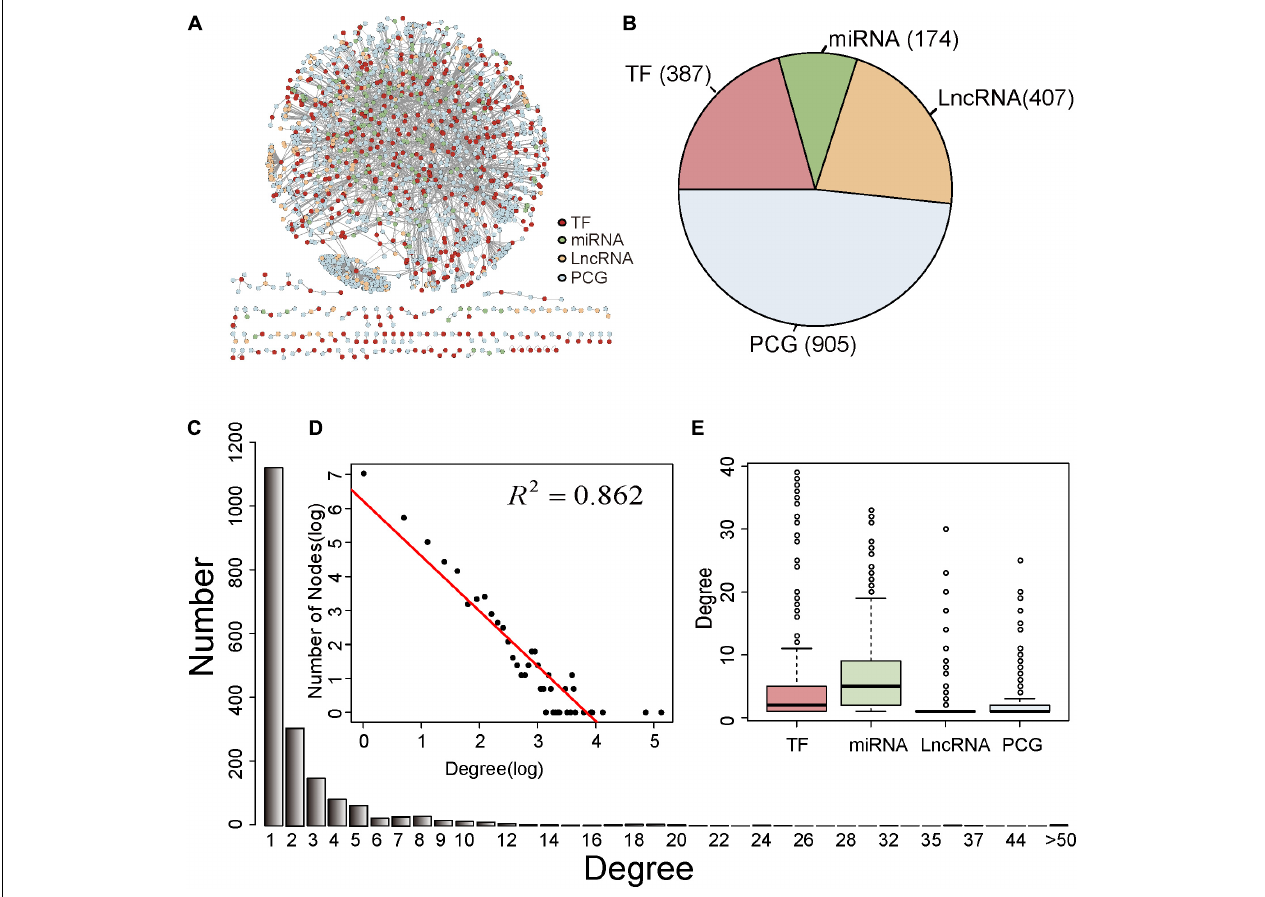
FIGURE 1 | Characteristics of the BC-specific CRN. (A) Overview of the BC-specific CRN. The TFs, miRNAs, lncRNAs, and PCGs were red, green, yellow, and blue colored. (B) The proportion of TFs, miRNAs, lncRNAs, and PCGs in the CRN. (C) Degree distribution of all nodes in the CRN. (D) The log-log plots for the degree distributions of all nodes in the CRN (E) Degree distributions for TFs, miRNAs, lncRNAs, and PCGs in the CRN.